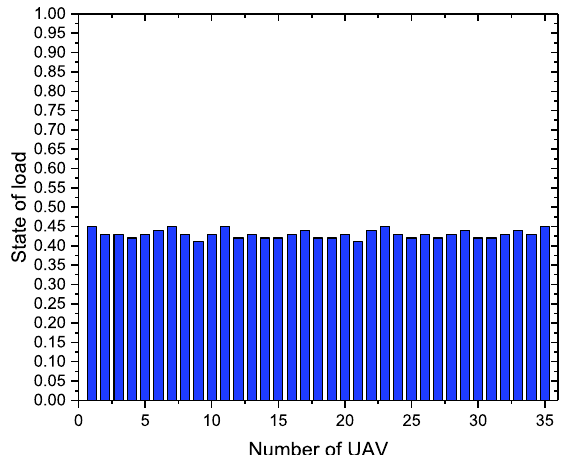
Figure 7. The load status of the UAV group when the UAV-enabled MEC system is running for 35 min.